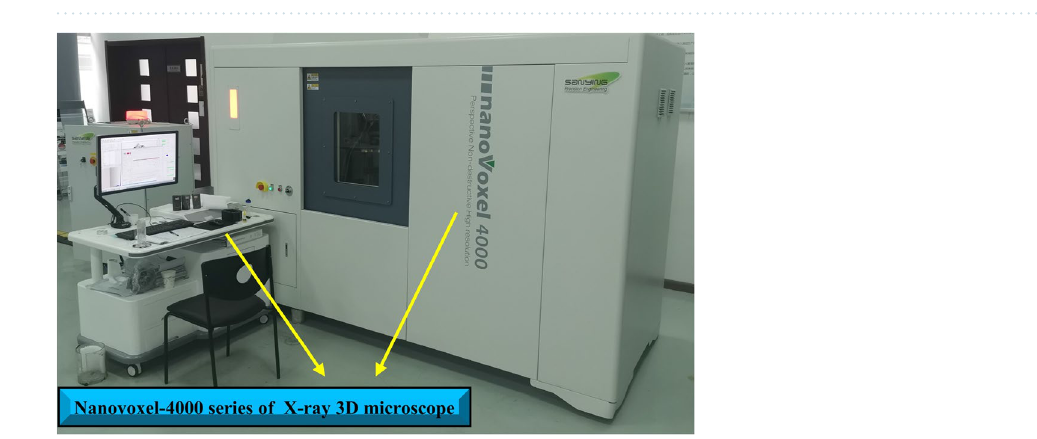
Figure 4. Nanovoxel-4000 series of high-resolution X-ray 3D